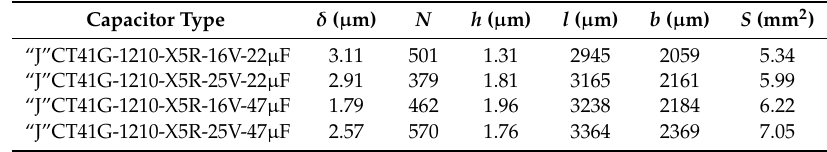
Table 1. Capacitance specifications and measurement parameters.